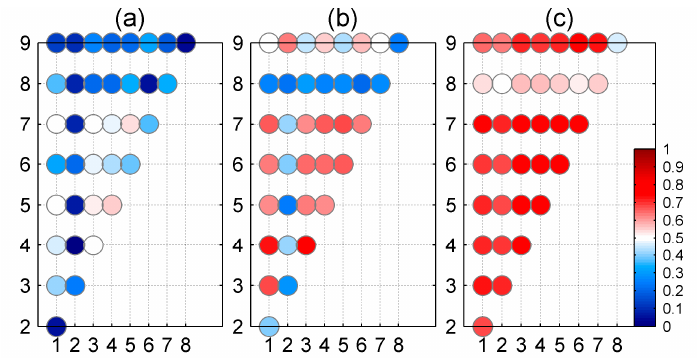
Figure 2. Correlation coefficients of ( a ) east, ( b ) north, and ( c ) up components for any two GPS stations. The numbers labeling the axis denote the stations listed in Table 1.